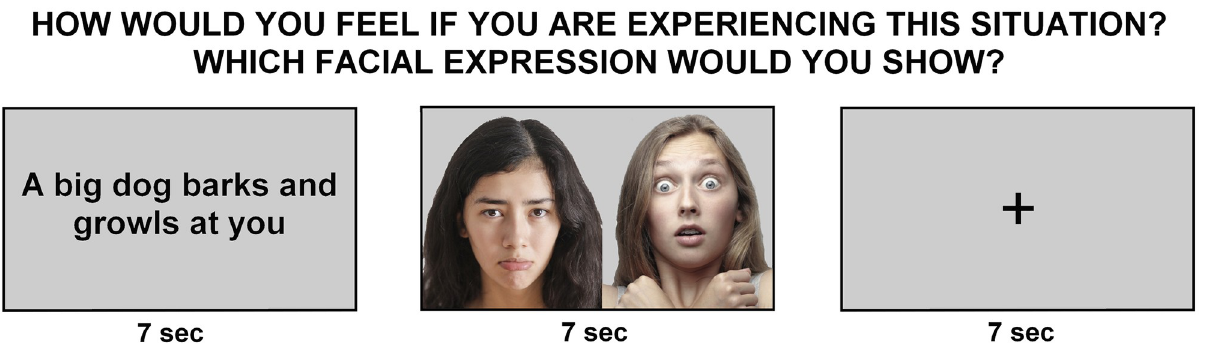
Fig 2. Illustration of the emotional response task. In every trial a short sentence with negative or neutral valence was presented, after which the participant was asked to choose between two emotional face stimuli of other people (one correctly matched and one wrongly) and had to select the facial expression that best matched the induced feelings. The paradigm consisted of 30 negative emotion trials (10 anger, 10 fear, 10 disgust) and 10 neutral trials. The stimulus displayed here is not one of the originals used in the experiment, but a high-resolution reproduction suitable for printing and display. Image attribution: Andrea Piacquadio/Pexels (left and right faces).